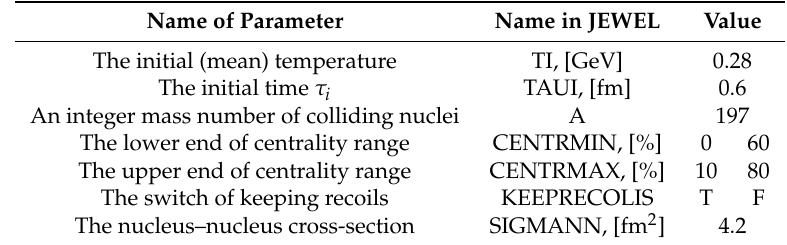
Table 2. Parameters of the JEWEL simulation with medium for central and peripheral “recoils on/off” collisions